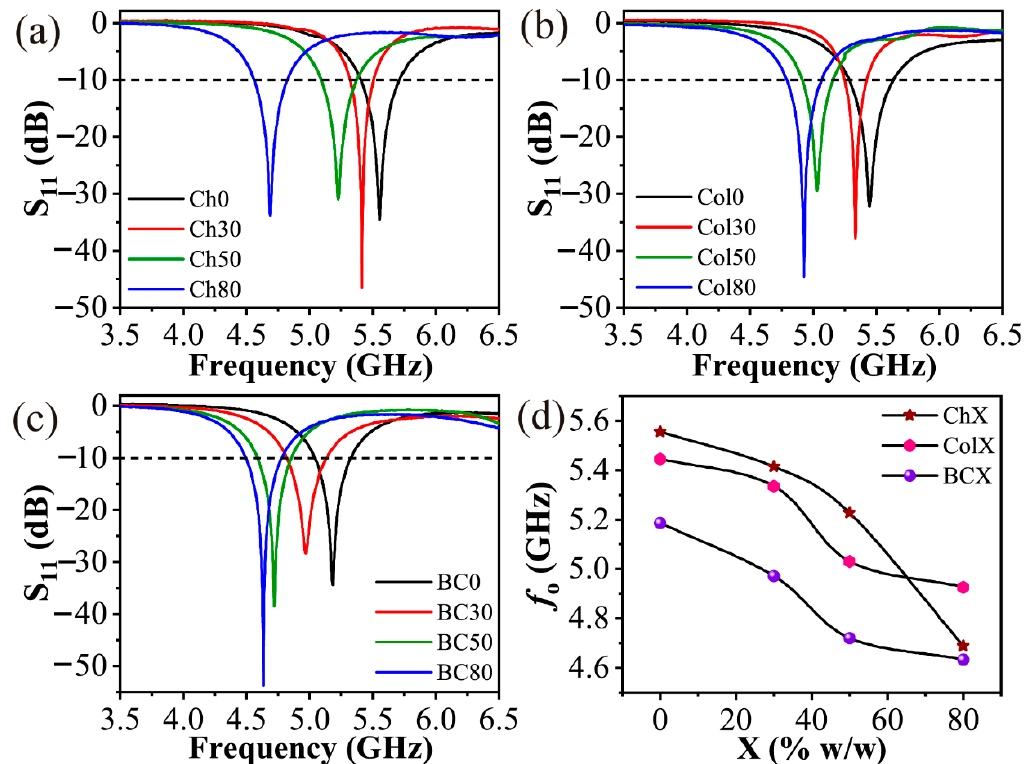
Figure 9. Measured reflection coefficient S 11 of microstrip antennas prototypes of ( a ) Ch-based films (0–80% of SPIONs); ( b ) Col-based films (0–80% of SPIONs); and ( c ) BC-based films (0–80% of SPIONs). ( d ) Variation of operation frequency in function of the composition of microstrip substrate. Table 3. Calculated and experimental operating frequencies and bandwidths for prepared microstrip antennas.